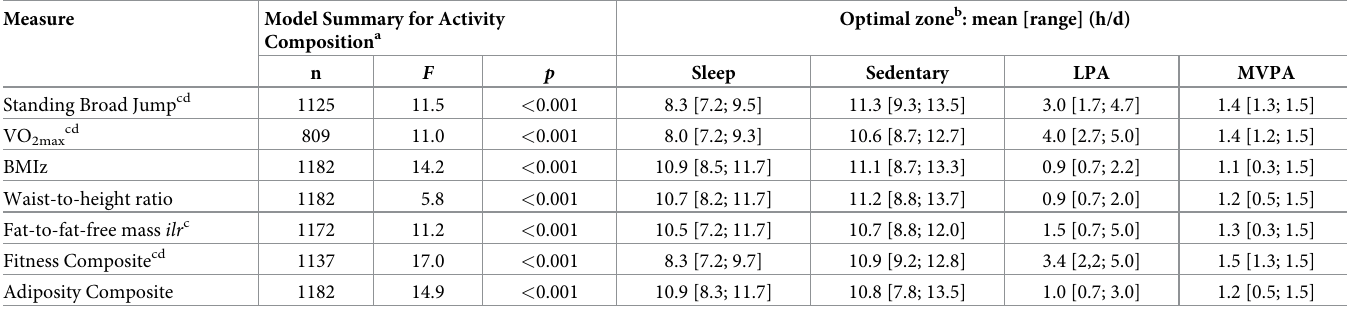
Table 2. Relationships between activity composition and outcomes: Type III ANOVA model summaries and estimated optimal activity zones for fitness and adi- posity outcomes.